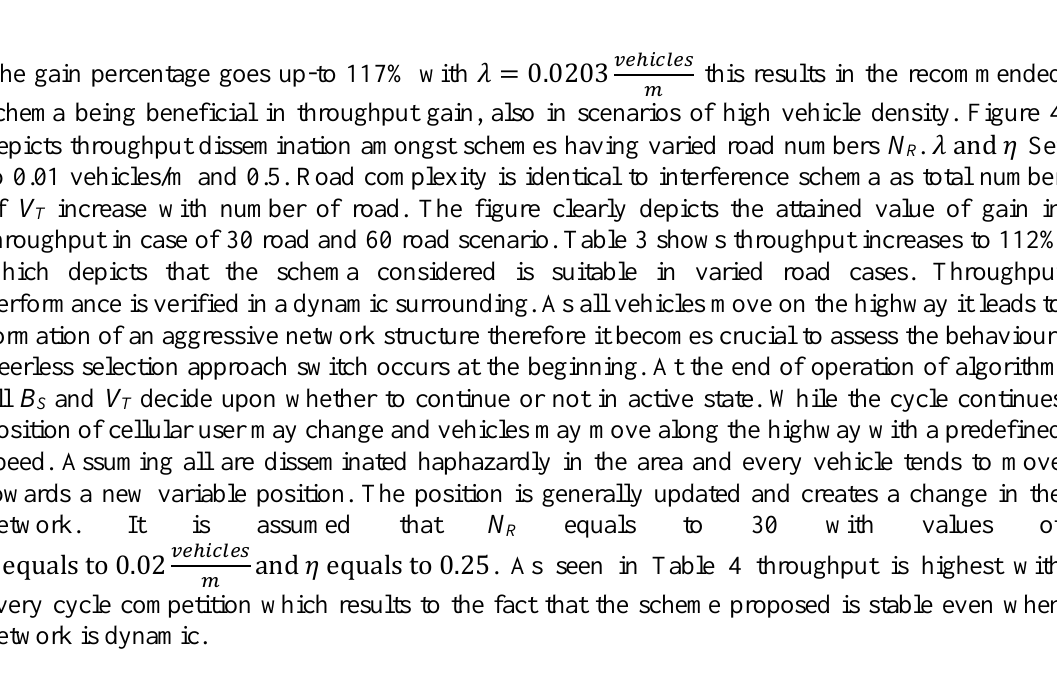
Table 3 : Throughput comparison between different schemes under different 𝑵